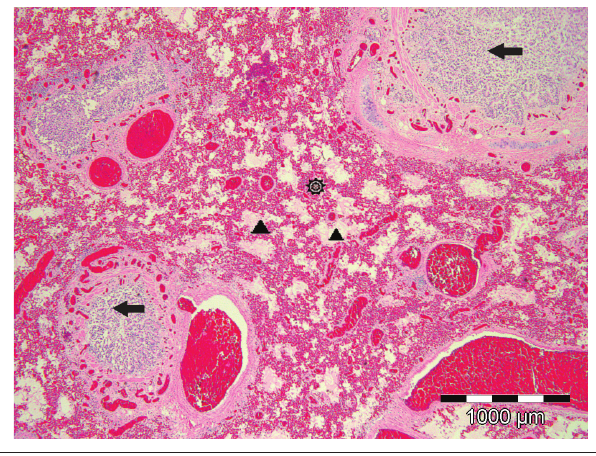
FIGURE 3: Low magnification of paraquat-induced extreme diffuse pulmonary congestion (star), high protein alveolar oedema (arrowheads) and honeycomb pattern of dilated respiratory bronchioles (arrowheads) and alveolar ducts with surrounding alveolar collapse (star) (HE x 40). Bronchiolar epithelium showing hyperplasia as well as degeneration, necrosis and desquamation into the bronchiolar lumens (horizontal